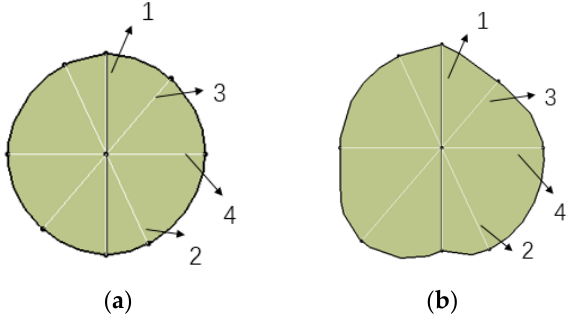
Figure 9. Shape of planar disk: ( a ) regular plate; ( b ) irregular plate.